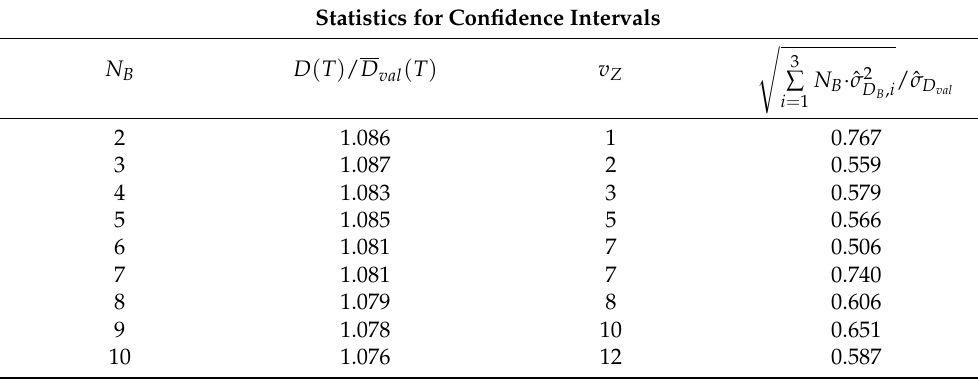
Table 4. Statistics calculated from measured non-stationary stress-time history. Statistics for Confidence